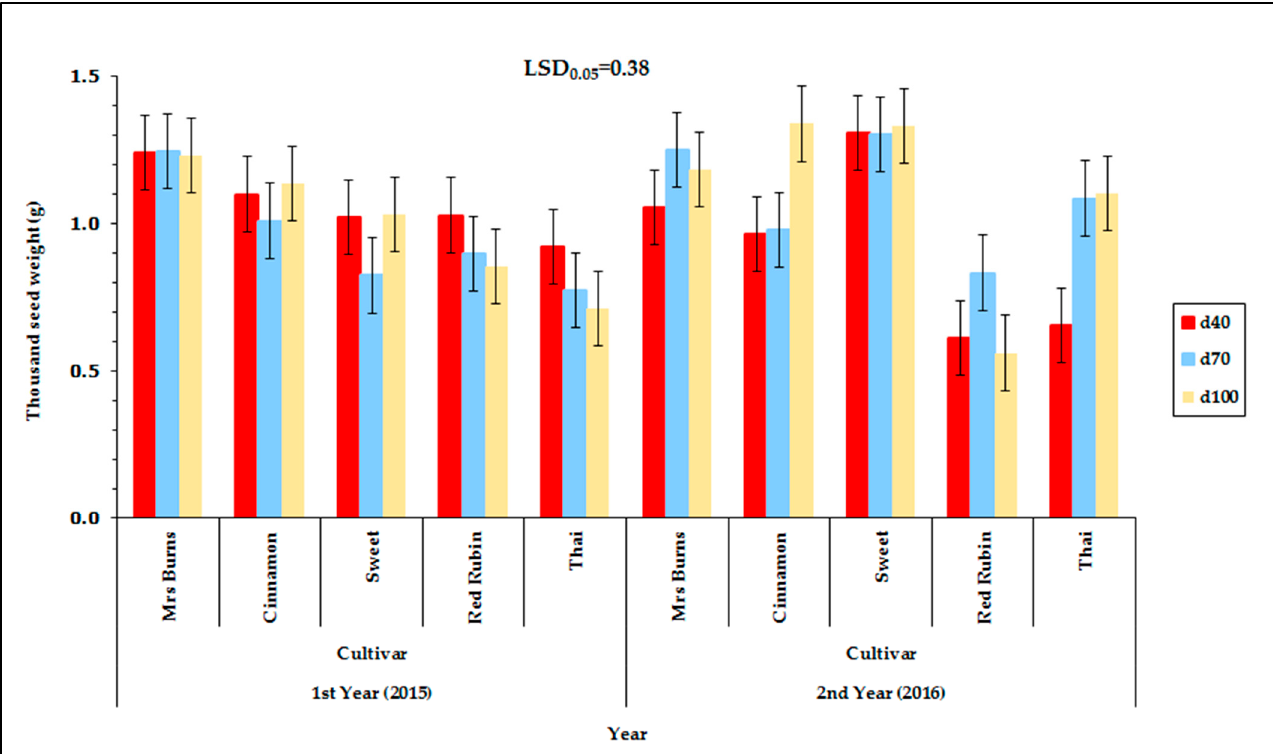
Figure 2. Thousand seed weight (TSW) of the five basil cultivars (“Mrs Burns”, “Cinnamon”, “Sweet”, “Red Rubin”, and “Thai”), at the three levels of irrigation (d 40 , d 70 , and d 100 ), at the two years of experimentation. Data presented are estimated mean values, where LSD is the least significant difference at the 0.05 significance level. Error bars correspond to the estimated common standard error of the mean values. Each mean value has been estimated utilizing n = 4 measurements. Figure S2 (see Supplementary Material) presents the observed mean values and the corresponding individual standard errors.